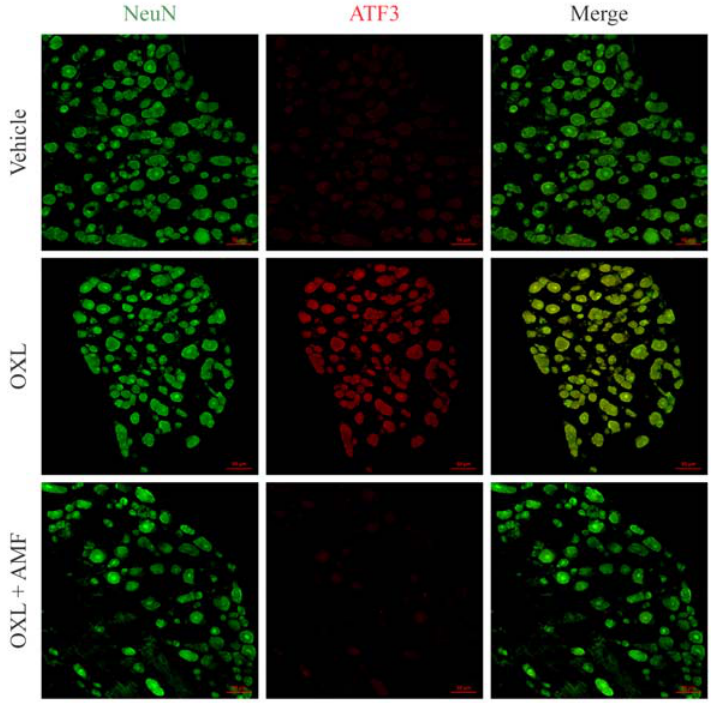
Figure 5. Activating transcription factor 3 (ATF3) expression in the dorsal root ganglia on the 28th experimental day. Green: neuronal marker (NeuN); red: ATF3; merge: yellow. Magni fi cation 200 (cid:1) , scale bar 50 m m. OXL: oxaliplatin; AMF: